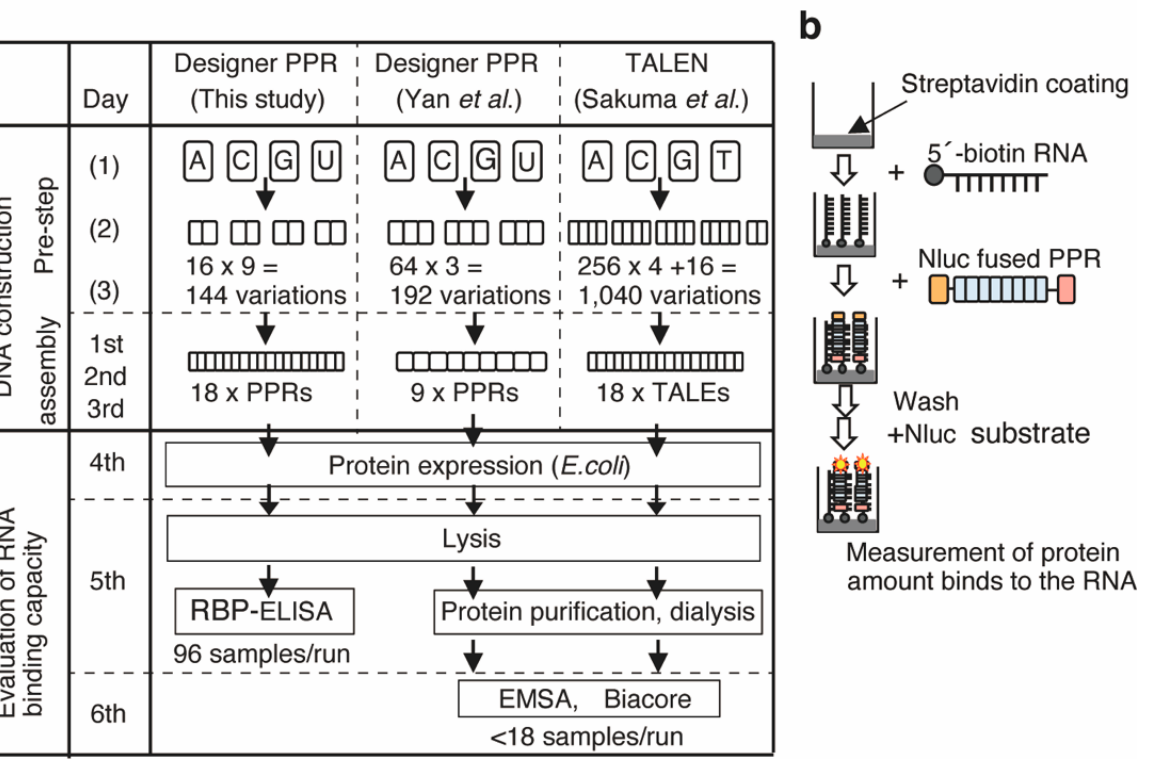
Figure 1. Fast assembly and evaluation system for the designer PPR protein. ( a ) Scheme for seamless repeat assembly of the PPR ([32] and this study) and TALEN [30] genes and evaluation of the RNA binding affinity and specificity using RBP-ELISA for the recombinant PPR protein. ( b ) Experimental flow of the RNA-binding protein ELISA (RBP-ELISA).